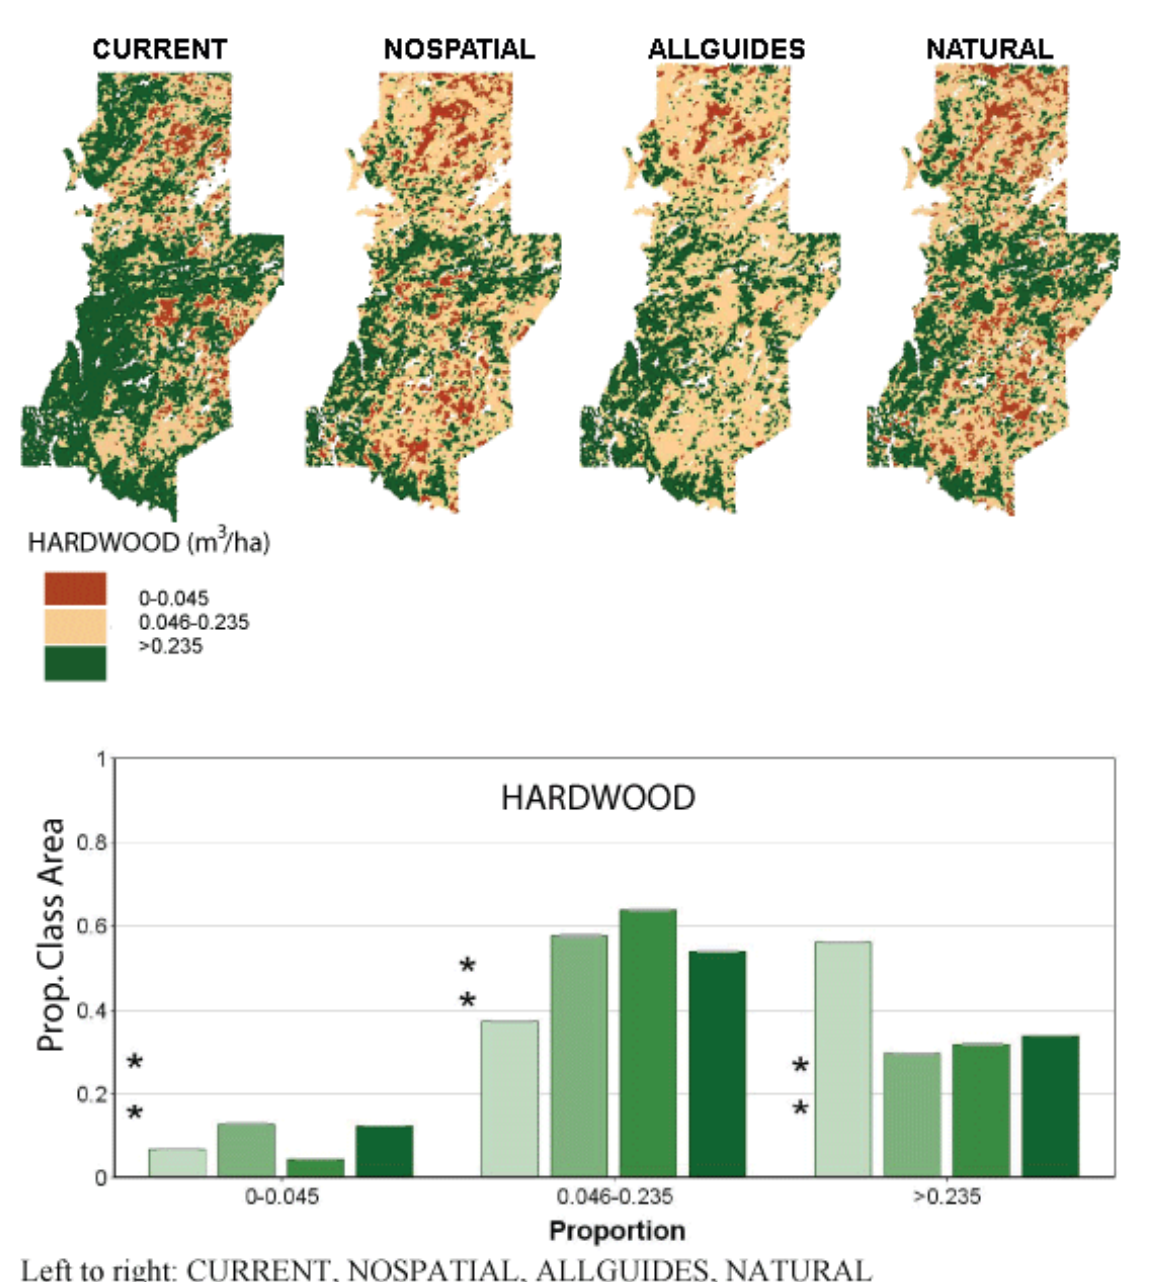
Fig. 8. Spatial pattern signatures for percent hardwood volume (HARDWOOD) based on Patchworks projections (year 100) of four management scenarios (see Table 2 for definitions). Histograms depict proportion of map-area for low, medium, and high HARDWOOD for each of the four scenarios, and asterisks represent SRNV for HARDWOOD. Proportions are treated as percentages for